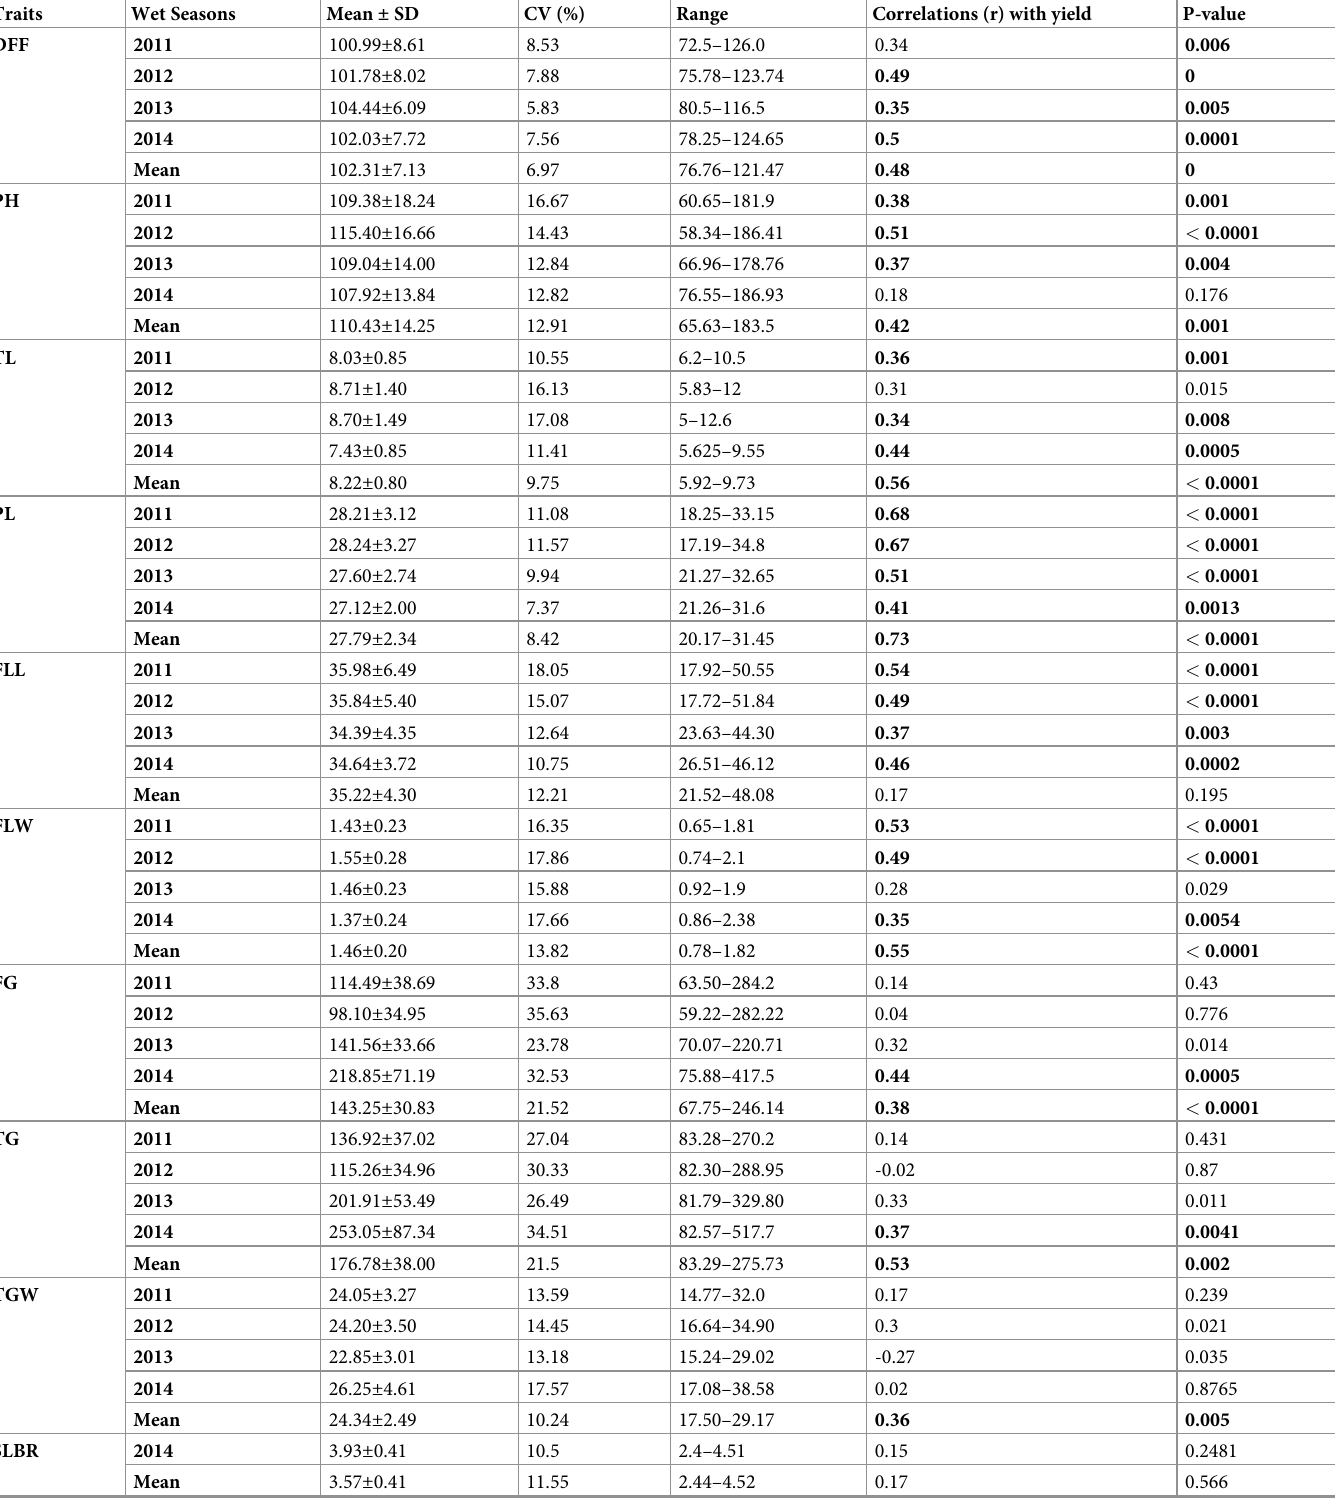
Table 1. The performance of 60 genotypes in four seasons based on grain yield and yield-related traits.